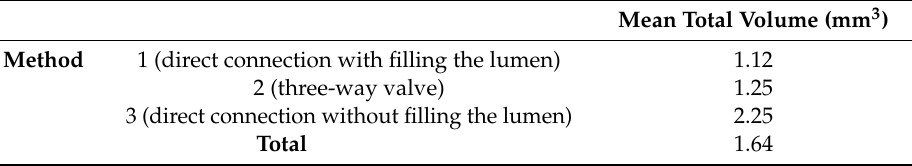
Table 8. Mean total volume depending on the